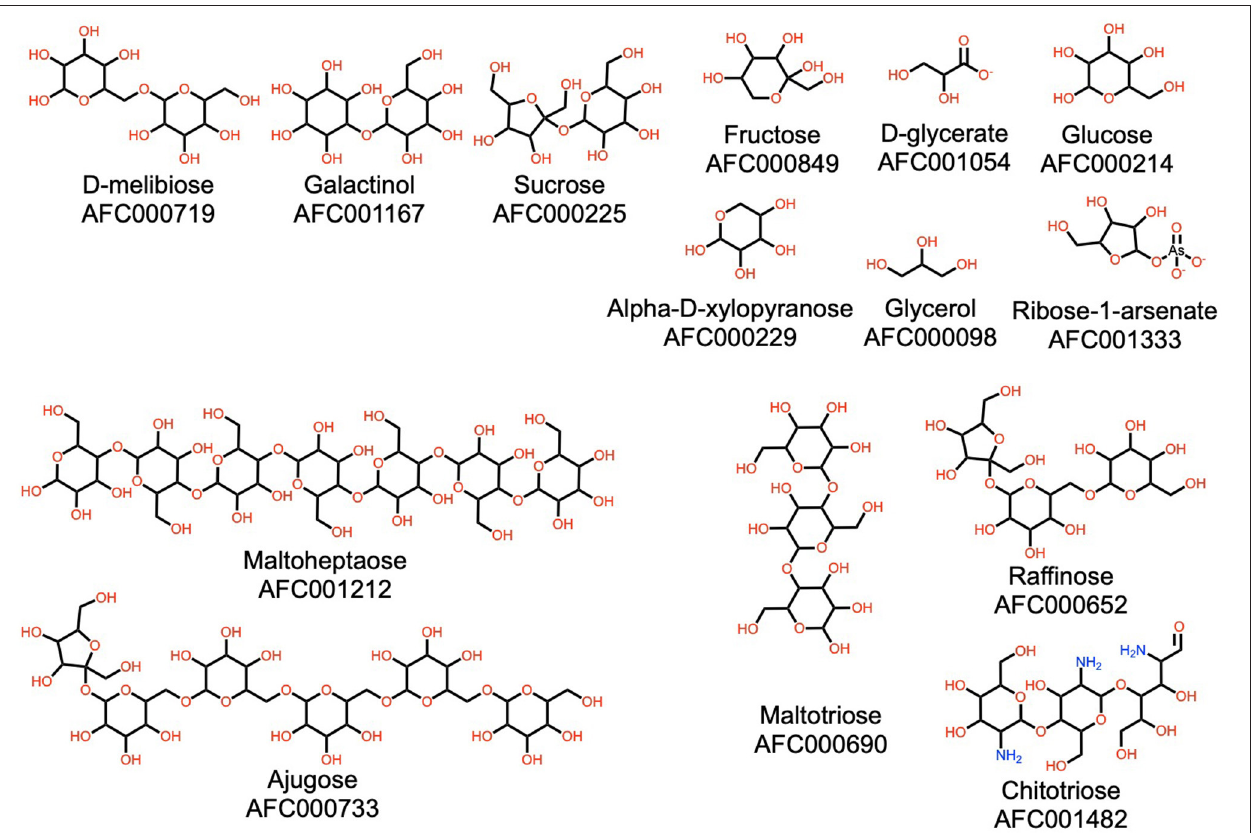
FIGURE 4 | Illustration of the diversity of carbohydrates in watermelon. AFC identifiers are defined in Materials and Methods, section AFC